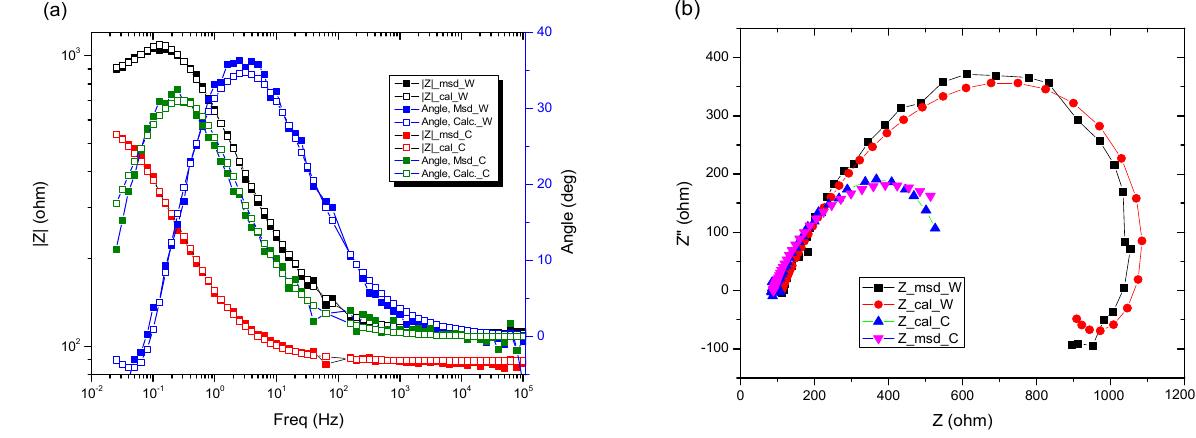
Figure 8. Electrochemical measurements of tested samples for ( a ) Bode plots, ( b ) Nyquist plots. In the circuit used in Table 6, R s , Q, and R ct have the same meaning as in the previous circuits; Q and R ct characterize the double-electric layer that controls the corrosion rate, in the Nyquist diagram being represented by the capacitive loop in the dolmen of high frequencies. In the same circuit W represents an inductance and R L is the total resistance of the adsorbed particles on the surface unit of the sample.